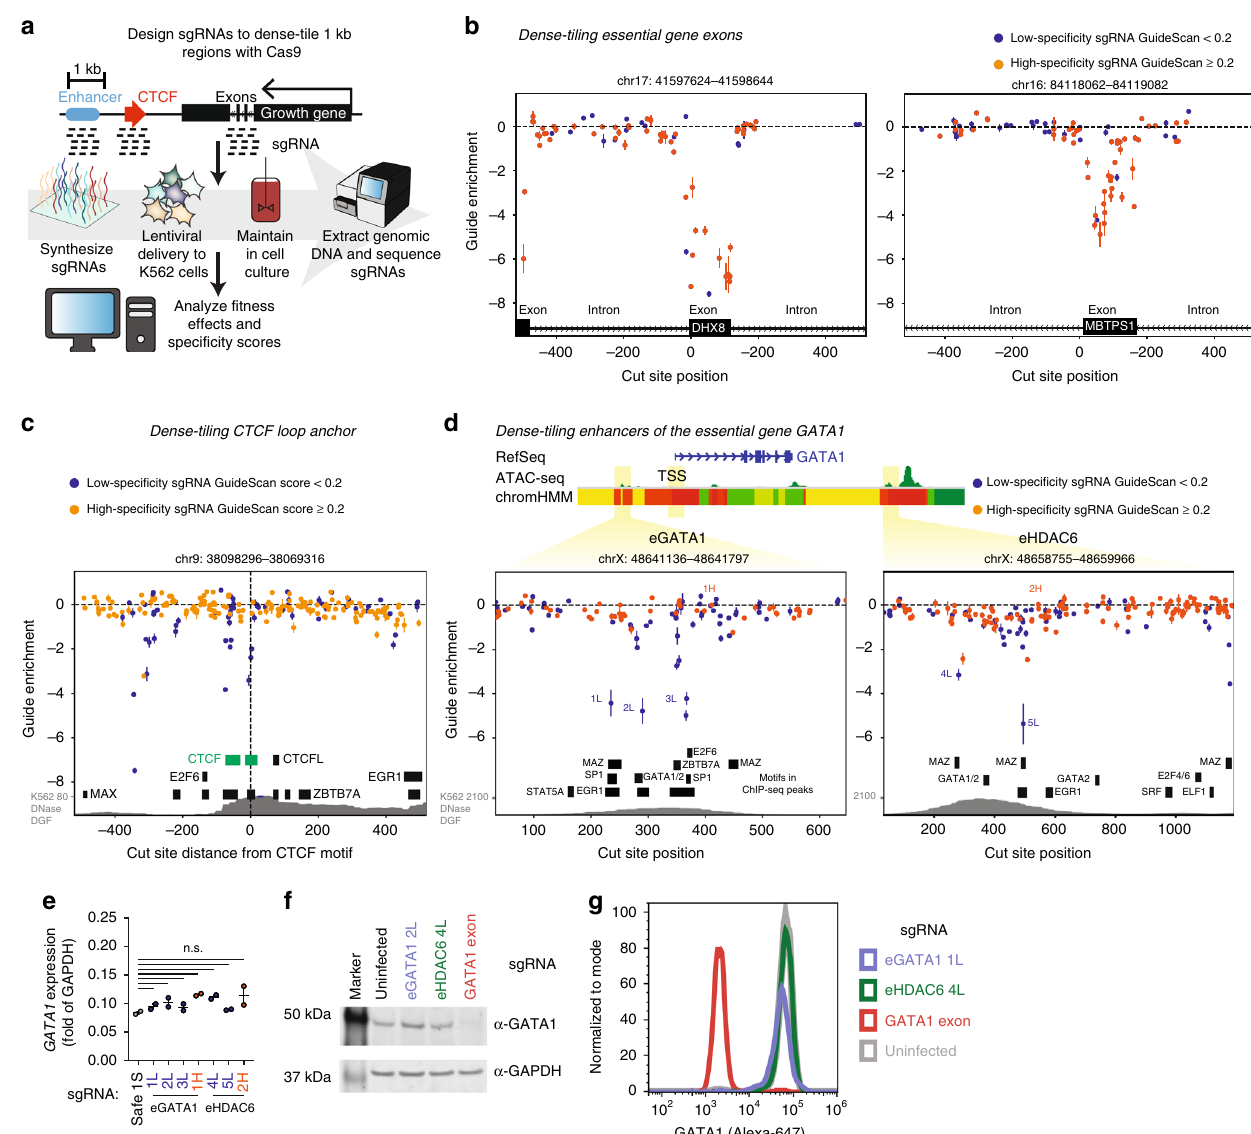
Fig. 2 Low-speci fi city sgRNAs confound identi fi cation of essential motifs in dense-tiling screen of loop anchors and enhancers. a A dense-tiling Cas9 growth screen was performed with sgRNAs densely tiling two types of regions: (1) 1 kb windows around select hit and non-hit CTCF loop anchors from the CTCF motif screen and (2) two enhancers of GATA1 , previously called eGATA1 and eHDAC6. b As a positive control, we veri fi ed that the dense-tiling screen correctly maps the boundaries of exons of essential genes with high-speci fi city sgRNAs. Each point is the average enrichment of two biological replicates and the bar is the standard error. c Dense-tiling screen results from a 1 kb region centered on a motif that was a false positive hit in the original motif-targeting screen (targeted with sgRNAs 15776 and 15777 and also shown in Fig. 1 and Supplementary Fig. 1). All evidence for the essentiality of a CTCF motif comes from low-speci fi city sgRNAs. Motifs in ChIP-seq peaks are shown as black boxes and CTCF motifs as green boxes. d Dense-tiling screen results from two regions containing enhancers of the essential gene GATA1 . sgRNAs selected for validation studies are labeled (e.g., 1 L represents the fi rst sgRNA with a low speci fi city score). ChromHMM is colored according to the 15-state scheme 76 (brie fl y, reds are predicted promoter states, yellows are enhancer states, and greens are other transcriptionally active states). e The enhancer motif-targeting sgRNAs identi fi ed in d do not signi fi cantly decrease GATA1 expression according to qPCR ( p > 0.05, ANOVA). Each dot is a sgRNA infection biological replicate. f The sgRNAs identi fi ed in d do not signi fi cantly decrease GATA1 protein expression according to Western blot. g The sgRNAs identi fi ed in d do not signi fi cantly decrease GATA1 protein expression according to fl ow cytometry for GATA1 protein level. Additional validation data are shown in Supplementary Fig. 4. Source data are available